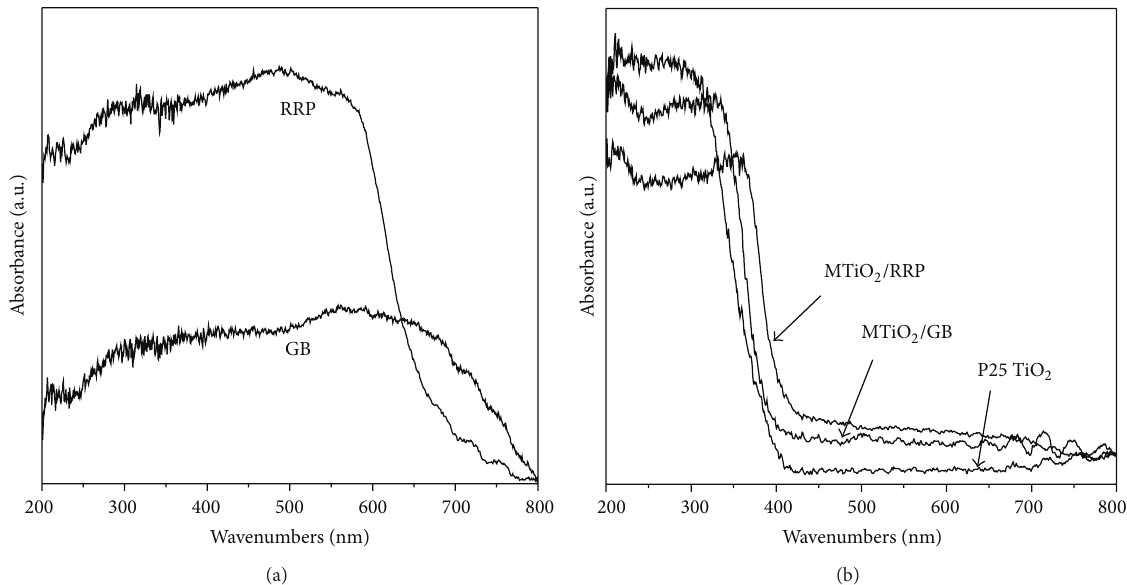
Figure 9: Comparison of absorption spectra of natural pigments RRP and GB (a); MTiO 2 /RRP, MTiO 2 /GB, and P25